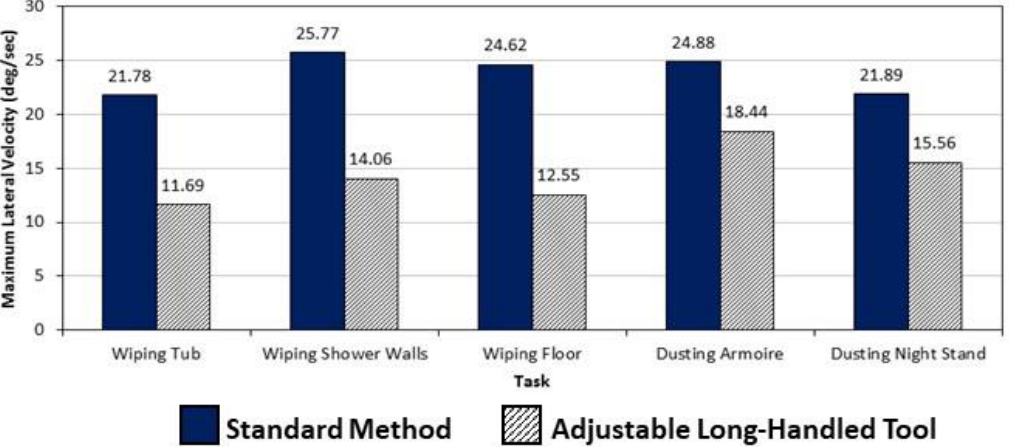
Figure 5. Differences in average maximum lateral trunk velocities between cleaning methods of five bathroom and furniture cleaning methods. All were significantly different ( p <